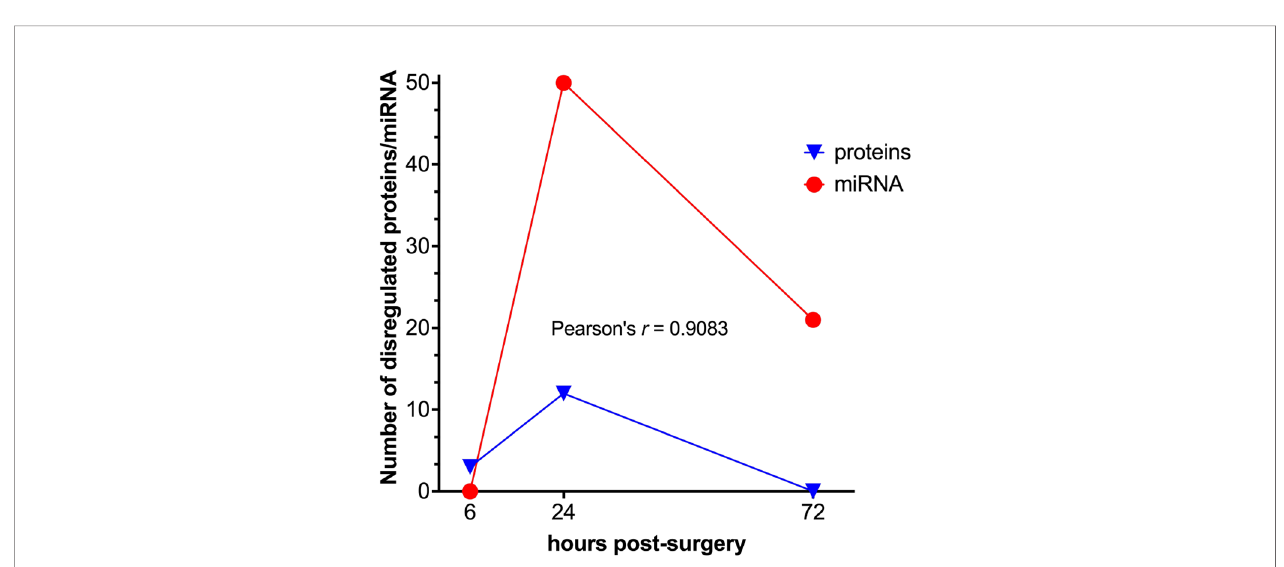
FIGURE 8 | Correlation analysis between the differentially expressed protein and miRNA data sets. Temporal kinetics of the differential expression of EVs ’ proteins and miRNAs demonstrates a high degree of correlation as to the Pearson ’ s linear correlation coef fi cient (GraphPad